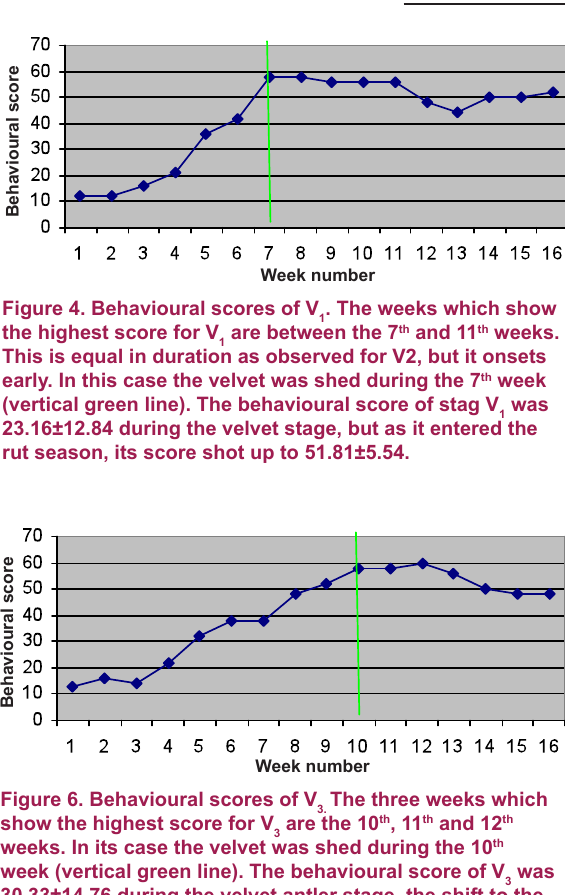
Figure 6. Behavioural scores of V show the highest score for V weeks. In its case the velvet was shed during the 10 th week (vertical green line). The behavioural score of V 30.33±14.76 during the velvet antler stage, the shift to the rut took the score up to